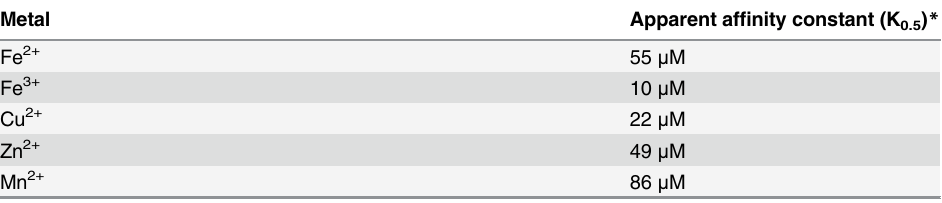
* The data represent the means of three determinations calculated as described in Materials and